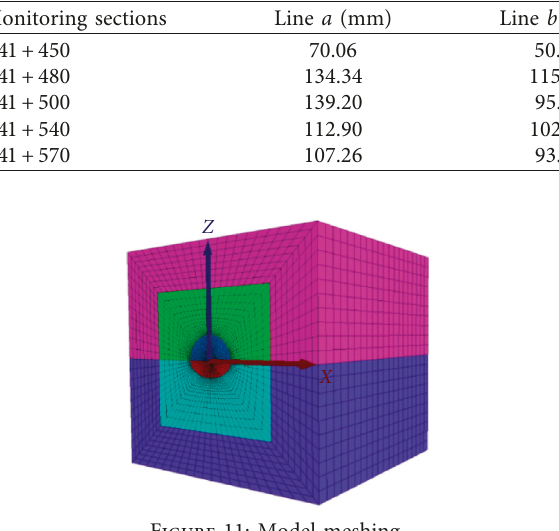
Table 1: Convergence values of partial section displacements of Gonghe Tunnel.